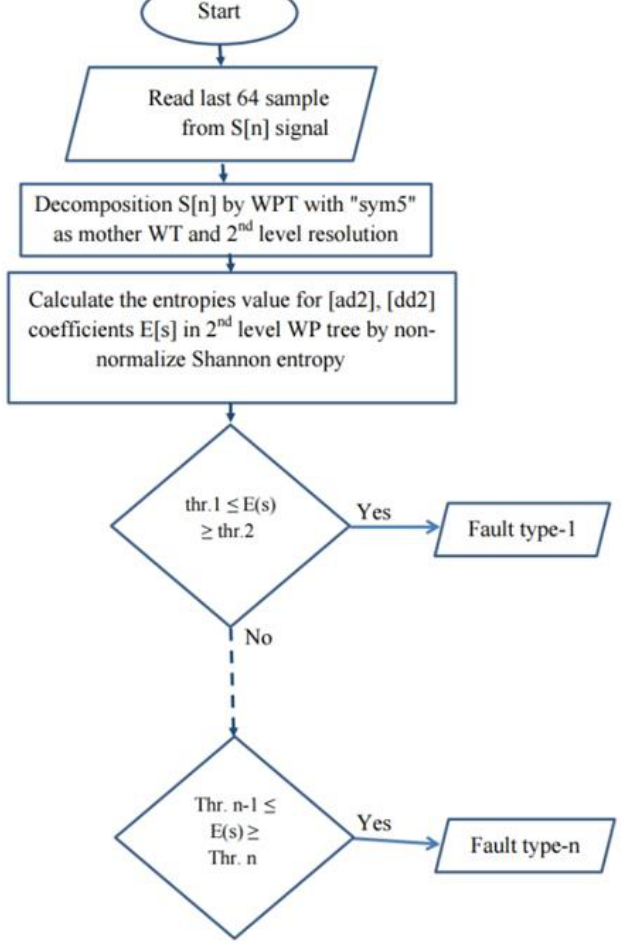
Figure 13. Block diagram of the proposed fault classification method.